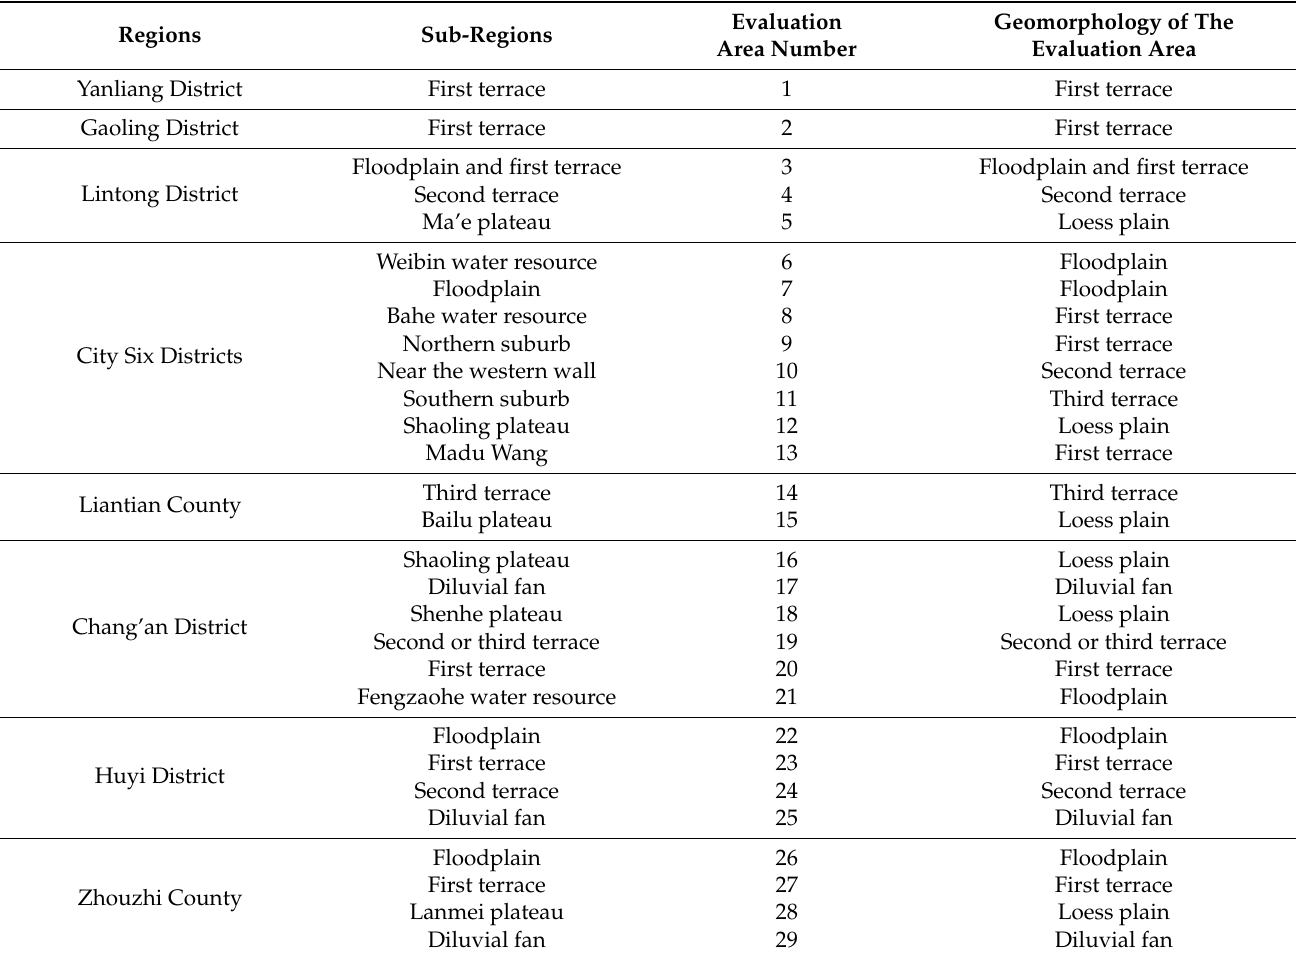
Table 2. Evaluation zoning table of groundwater carrying capacity in study